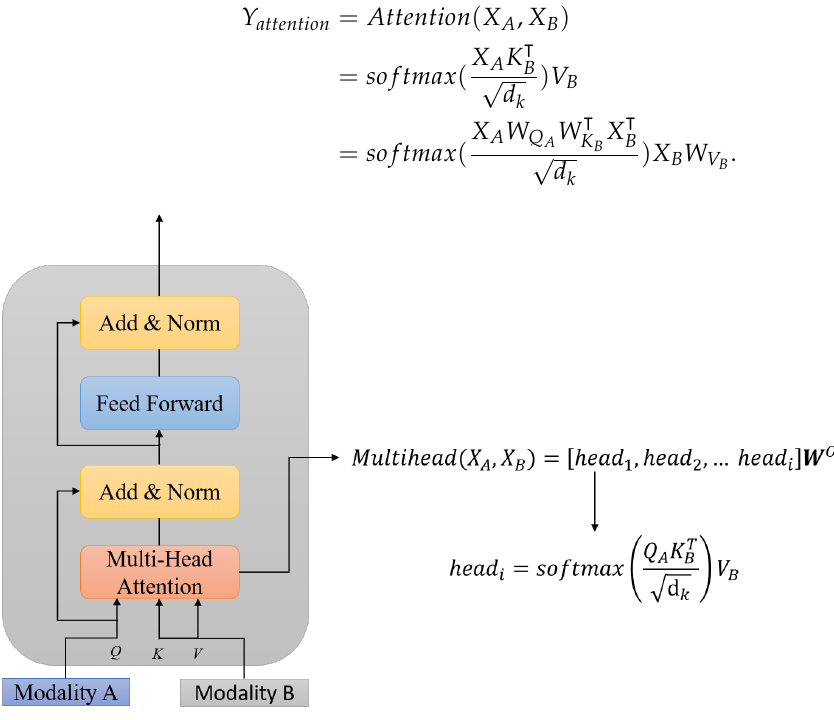
Figure 5. The architecture of the crossmodal